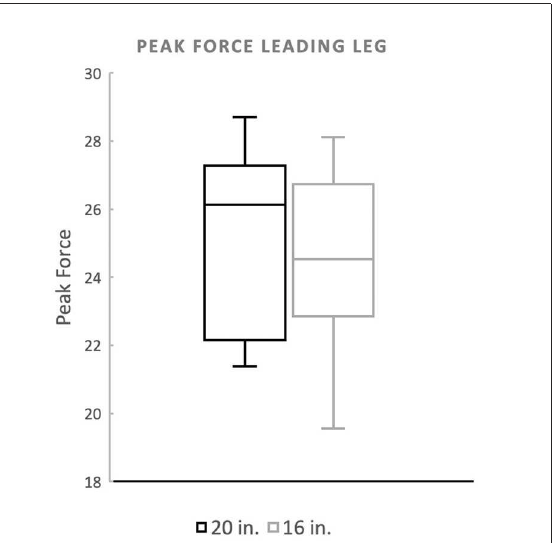
FIGURE4 Peak force of the leading forelimb. There was no significant difference between the standard (20 ′′ ) or preferred (16 ′′ ) height for the leading forelimb.